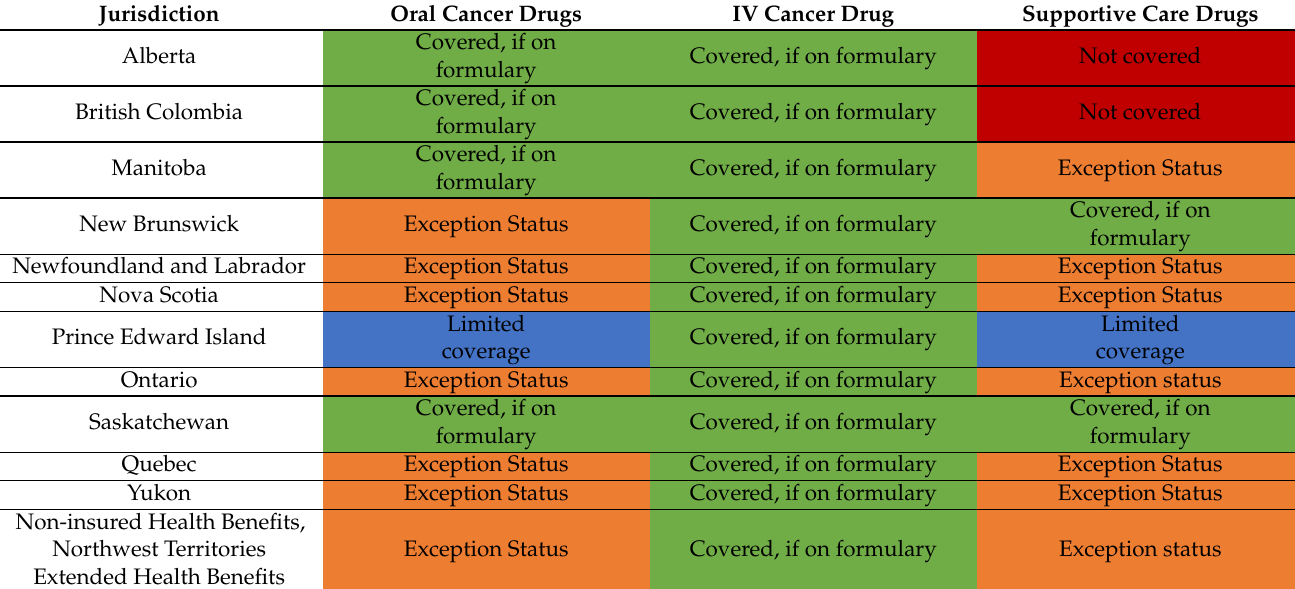
Table 1. Overview of public financial coverage of oral, intravenous (IV) cancer drugs and supportive care drugs by province, territory and federal insurance formularies. For supportive care drugs, we specifically looked at coverage for Neurokinin-1-receptor antagonists and pegfilgrastim. Jurisdictions may have different drugs on public formulary